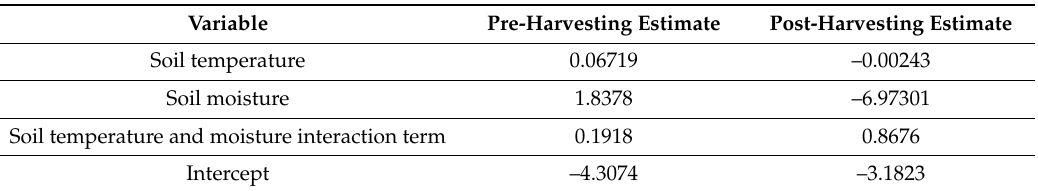
Table A2. Comparison of model parameter estimates for pre- and post-harvesting formulation of the best-fitted model (LN(Rs) ~ Ts*SM*THINNING